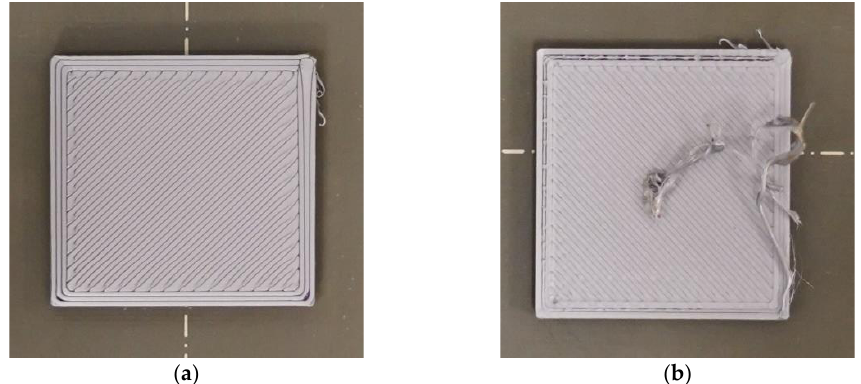
Figure 1. Photographs of ( a ) nondefective and ( b ) defective samples.